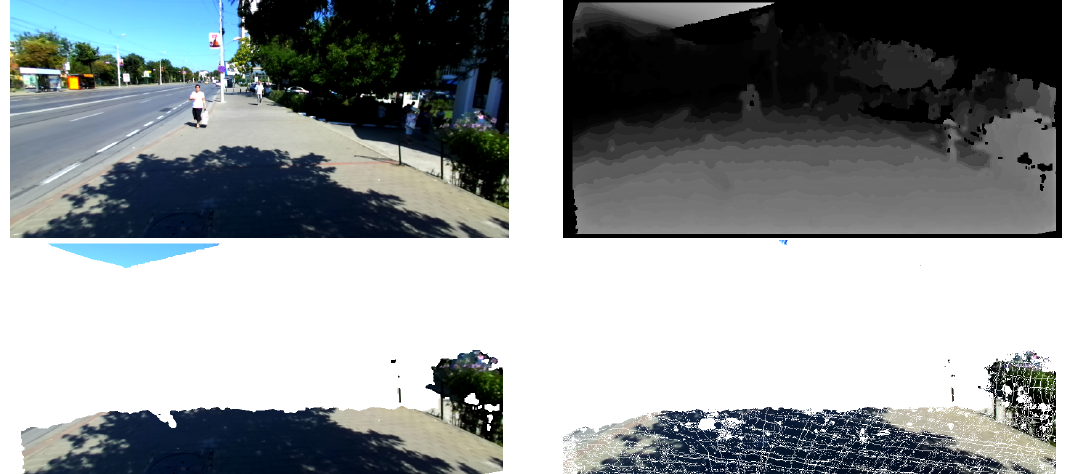
Figure 3. Comparison between our reconstruction and single frame based reconstruction. ( Top-left ) RGB image from the left camera. ( Top-right ) Disparity map computed with the approach of [33]. ( Bottom-left ) 3D reconstruction constrained within 5 m in front of the camera, based solely on the disparity map of the current frame. Errors in the estimation of the stereo correspondence lead to the presence of false structures in the reconstruction. ( Bottom-right ) Result of our incremental reconstruction showing the accumulated stable points (confidence above a predefined